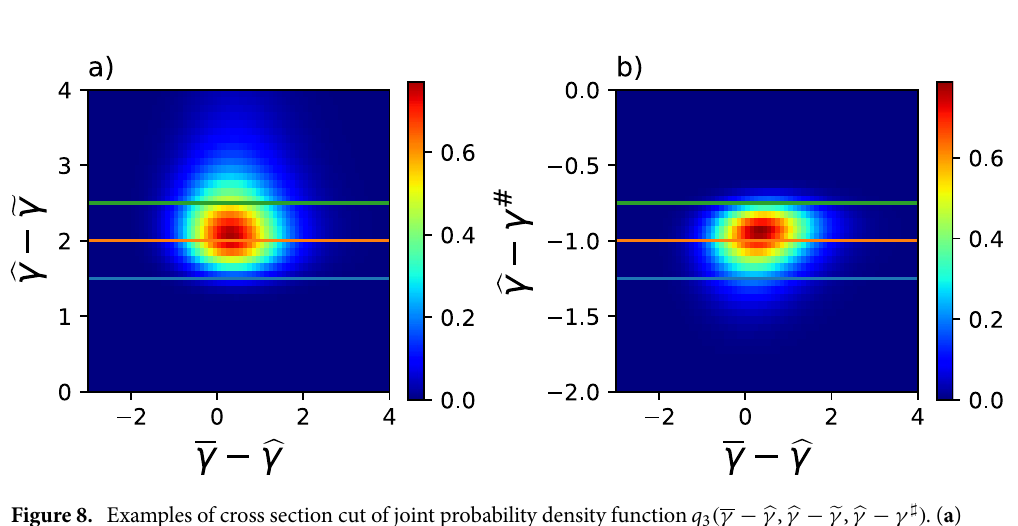
γ − γ = 1.5, 2, 2.5 , and ( b ) section cut q 3 ( · , 2, · ) with section lines (cid:31) (cid:30)